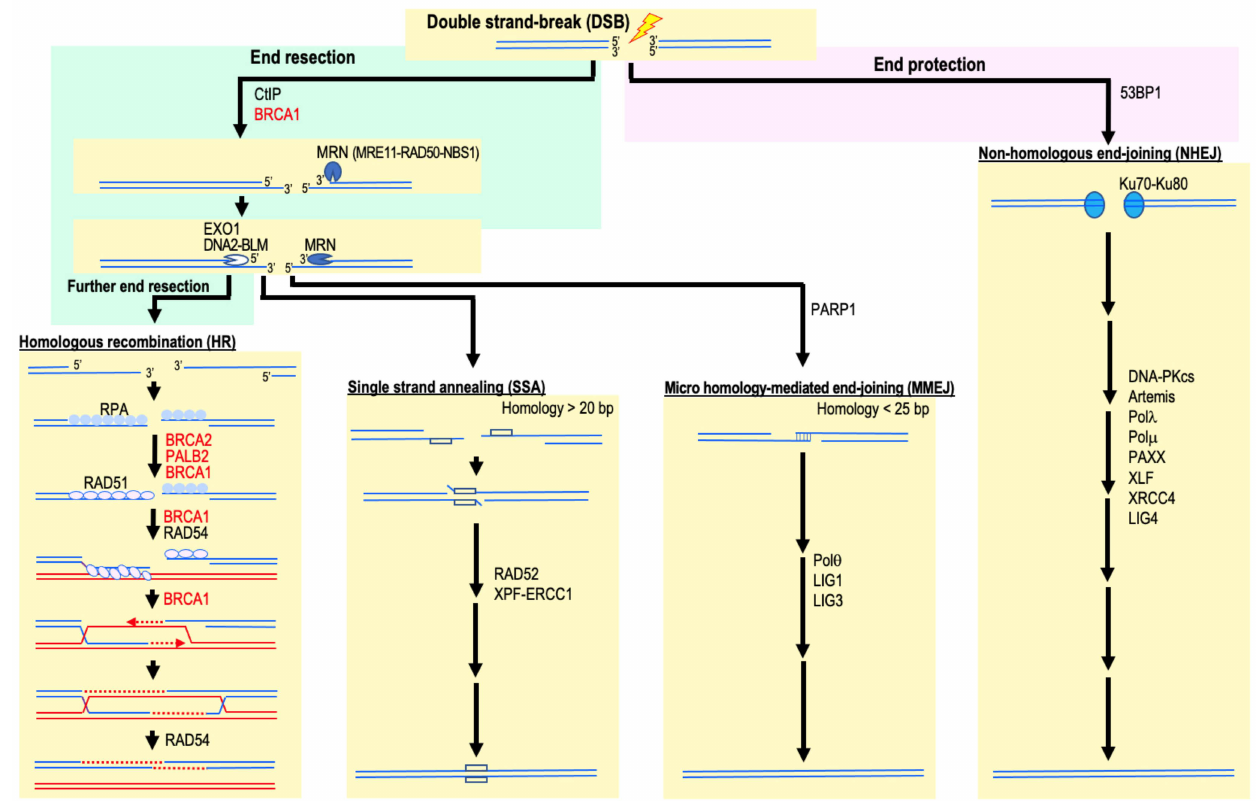
Figure 2. DSB repair pathways. Repair pathway choice is influenced by blocking or initiating end resection. Typical regulatory proteins of these pathways are indicated. At the molecular level, pathway choice is determined by either 53BP1 or BRCA1 and CtIP. CtIP and the MRN complex are involved in extensive 5 (cid:48) to 3 (cid:48) resection of the duplex-DNA to generate stretches of single-stranded (ss)-DNA at DNA ends for HR, SSA, and MMEJ. In HR repair, the ssDNA overhangs resulting from DNA end resection are coated with RPA, which is subsequently replaced by RAD51 in a BRCA2-DSS1 complex-dependent manner. RAD51 mediated strand exchange and its association with BRCA1, BRCA2, and RAD54 are essential for the further promotion of the HR